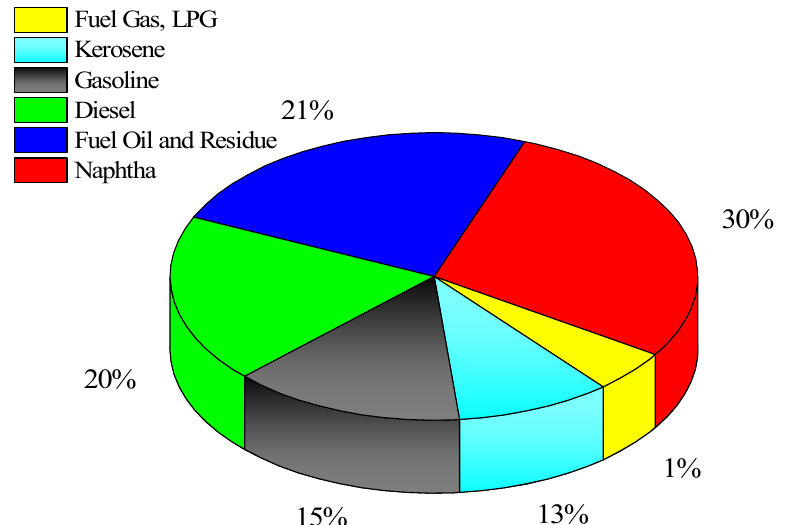
Figure 3. Crude oil distillation products [90].